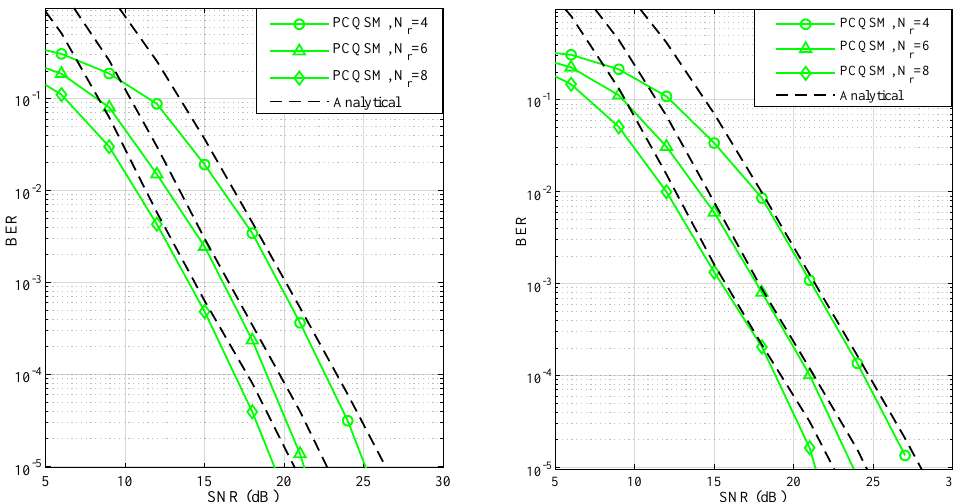
Figure 3. Theoretical performance of PCQSM in comparison with PCQSM simulation for ( a ) P = 2 and ( b ) P = 4 at a transmission rate of 14 bits/s/Hz with 8-QAM, N t = 8 and N r = 4,6, and 8, respectively.